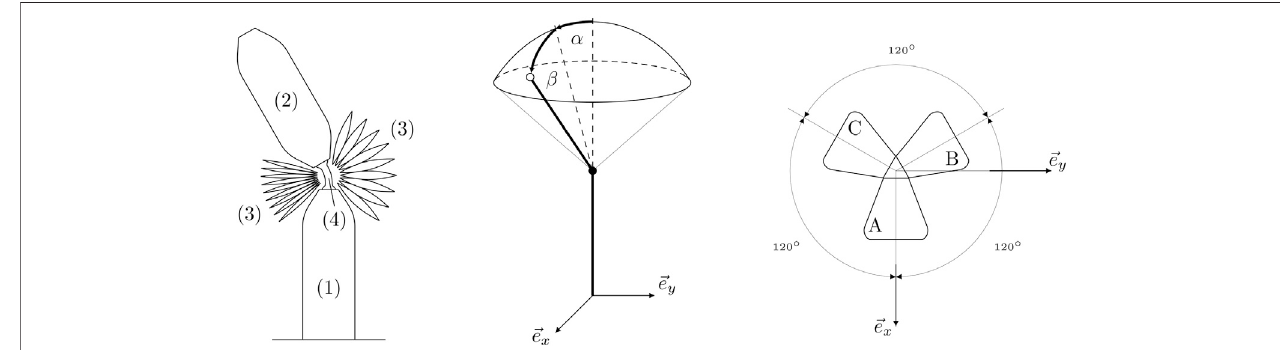
FIGURE 2 | A schematic of the soft robotic arm is shown in the left hand plot. The system consists of a static link (1) attached to the ground, a movable link (2), the in fl atablebellowactuators(3)andasoftjoint(4)placedbetweentheactuatorsandconnectingthetwolinks.Theorientationparametrizationofthesphericalroboticarmis shown in the middle plot. The static link is aligned with the inertial z -axis. A positive rotation of the movable link around the inertial x -axis is denoted by α and a positive rotationaroundtheinertial y -axisisdenotedby β .Thetopviewoftheactuatorcon fi gurationintheinertialcoordinateframeisshownintherighthandplot.Thethree actuators are arranged symmetrically around the inertial z -axis, where the actuator A is aligned with the inertial x -axis.